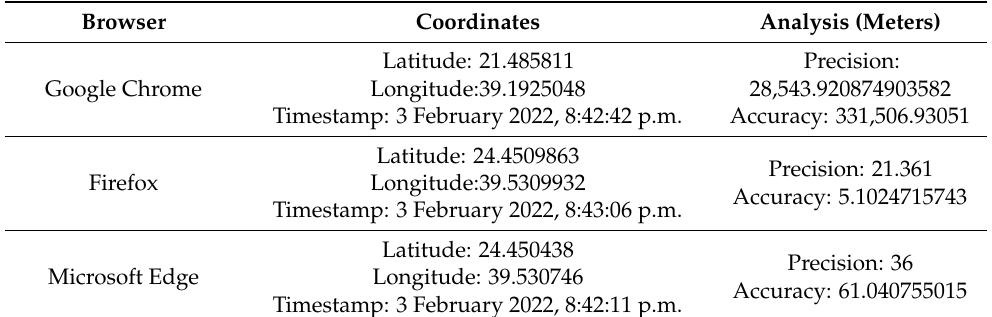
Table 3. Result and Comparison of W3C Geolocation API in Windows by a wireless network